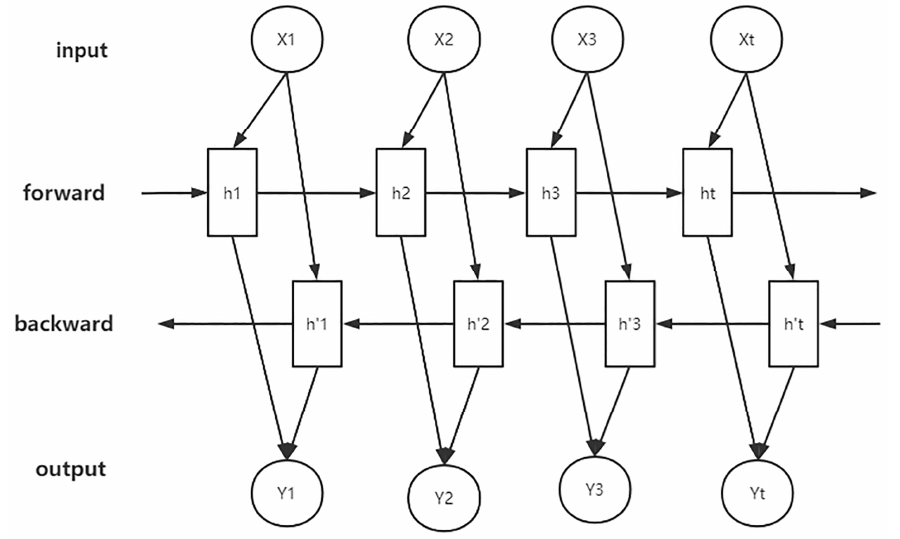
in RNN. Figure 3 is the structure of BiLSTM. BiLSTM is composed of two LSTM units, one